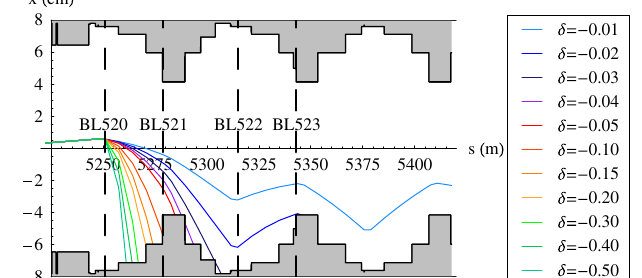
FIG. 5. (Color) Dispersive orbits of fragmented ions produced in one of the collimator jaws, shown together with the aperture. The collimator is located at s ¼ 5222 m at the left edge. The vertical dashed lines indicate the locations of the four BLMs closest downstream. A large fraction of the total losses occur at the aperture limitation at s ¼ 5277 m